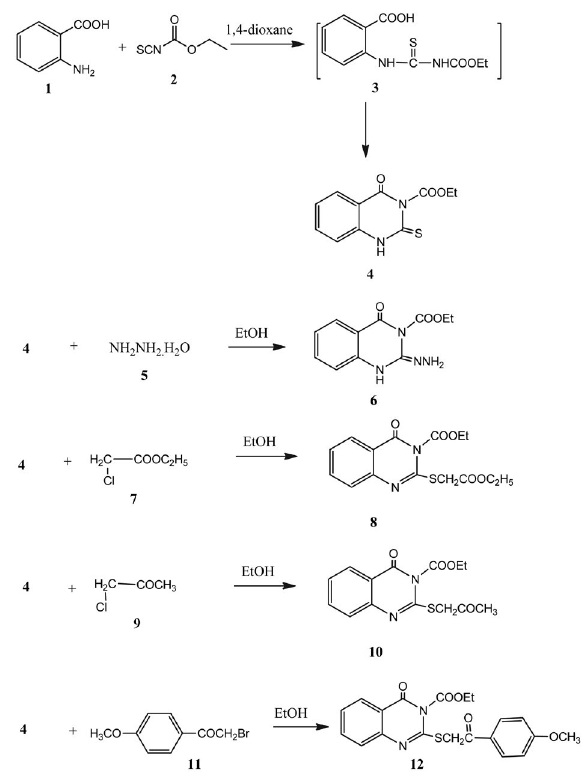
Scheme 1: Synthesis of compounds 4, 6, 8, 10 and